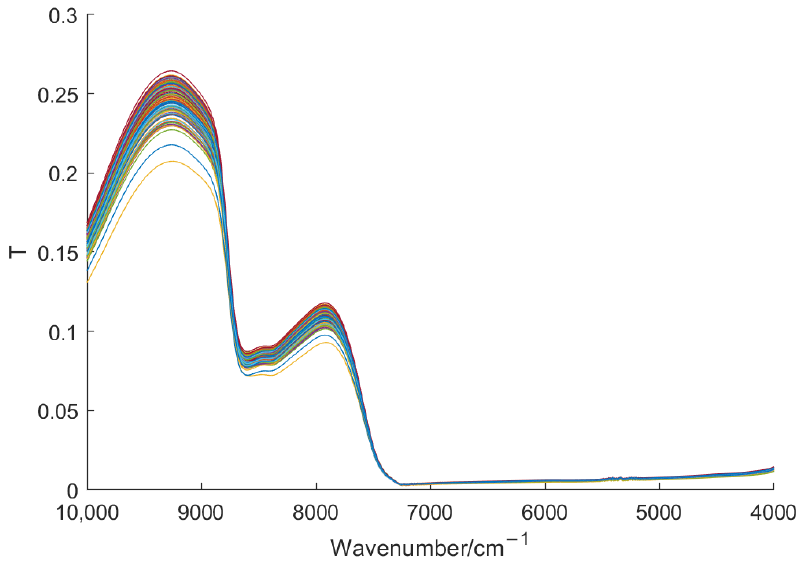
Figure 2. Transmittance spectra of Huangshan Maofeng tea.